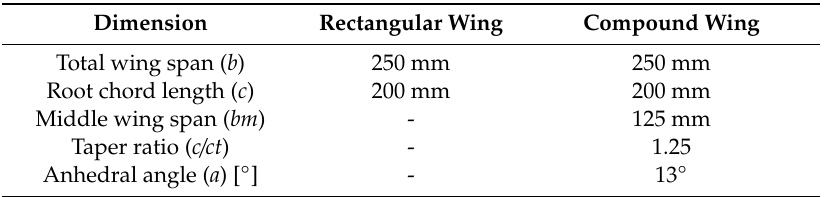
Table 1. Principle dimensions of the compound and rectangular